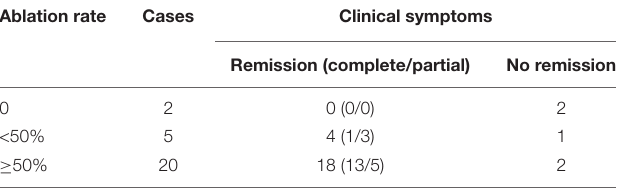
TABLE 7 | Ablation rates and clinical symptoms remission in 27 lesions. Ablation rate